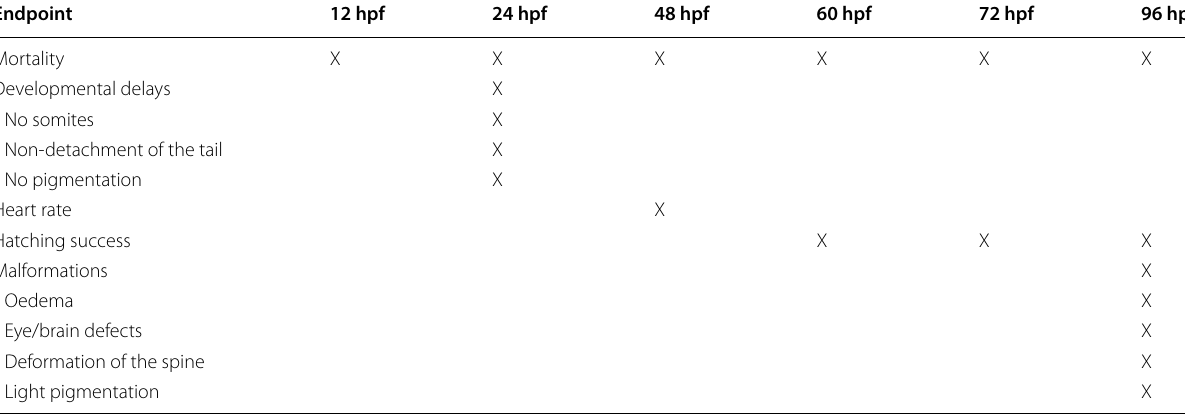
Eye/brain defects Light